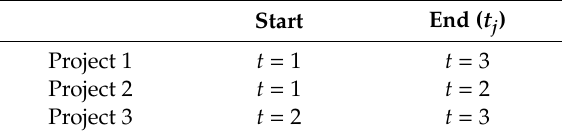
Table A16. Time period of project beginning and completion.